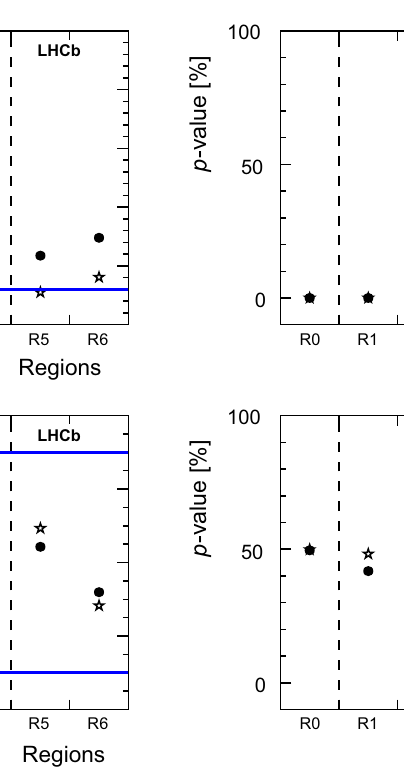
with n k = 50 for data collected in 2011 (stars) and 2012 (dots). The horizontal lines in the left figures represent -3 and +3 pull values. R0 corresponds to full Dalitz plot and R2 is separated into R5 and R6, and these regions are correlated and separated by dashed lines